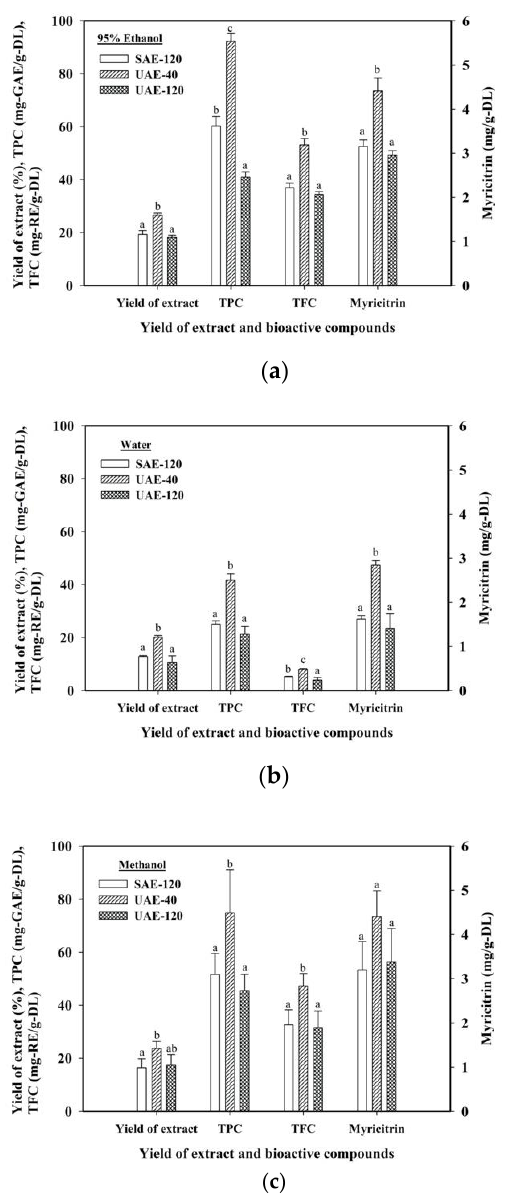
Figure 1. Comparison of the yield of extract, total phenolic content (TPC), total flavonoid content (TFC), and myricitrin between UAE-40, UAE-120, and SAE-120 with ( a ) 95% ethanol, ( b ) water, and ( c ) methanol as the solvent. Conditions: DL/solvent = 1/10 (g/mL), 30 °C, 4 h. Data were expressed as mean ± standard deviations from triplicate experiments. Different superscript letters at the same group were significantly different ( p < 0.05) using the Duncan’s multiple range test. Abbreviations: defatted leaves (DL), gallic acid equivalent (GAE), and rutin equivalent (RE).